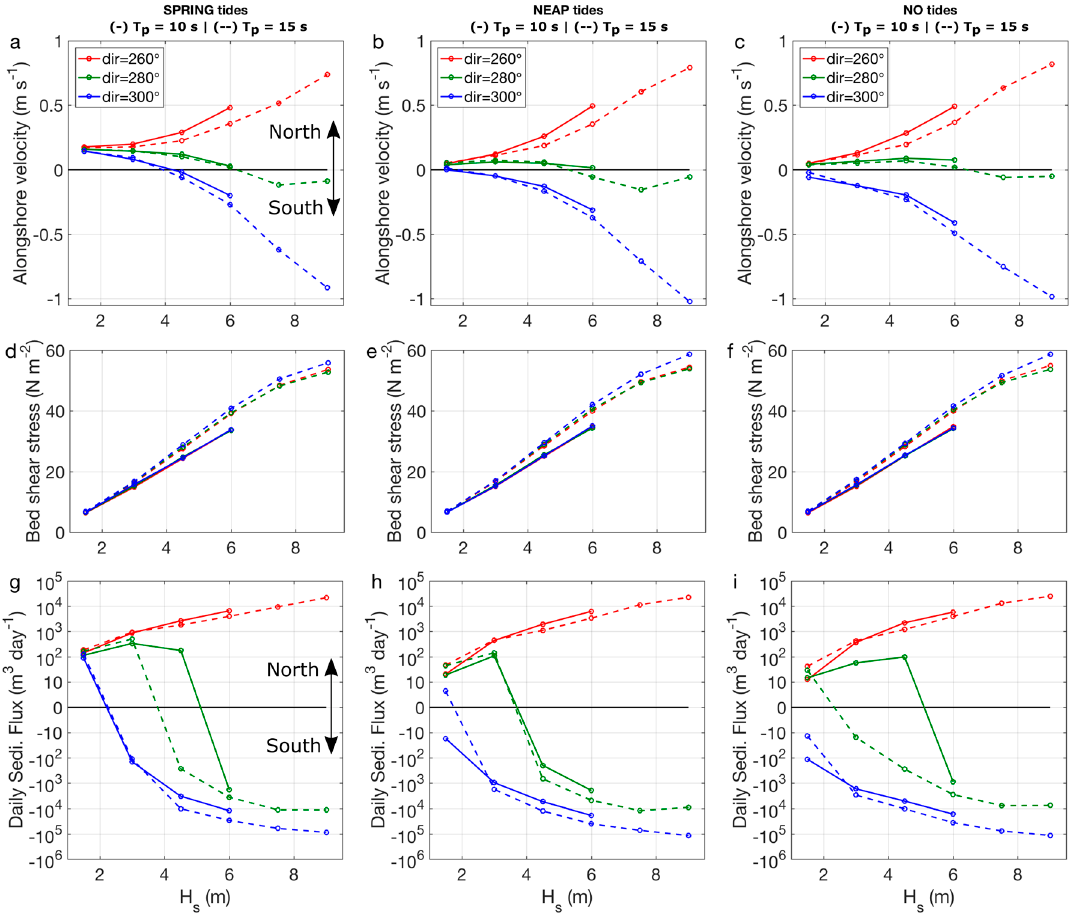
Figure 8. Summary of 90 synthetic model runs covering a range of wave–tide scenarios, each point represents a separate 25-h simulation. Alongshore velocity (top row) and bed shear stress (middle row) are averaged across transect T1 (Figure 2d); daily sediment flux (bottom row) is integrated across T1. Three tidal stages are simulated including spring tides (left column), neap tides (middle column), and no tides (right column). The y-axis for sediment flux (bottom row) has a log-scale; all other axes are linear. The line colour indicates offshore wave direction, including the following: red (260°); green (280°); and blue (300°). T p = 10 s is indicated with solid lines; T p = 15 s is indicated with dashed lines.